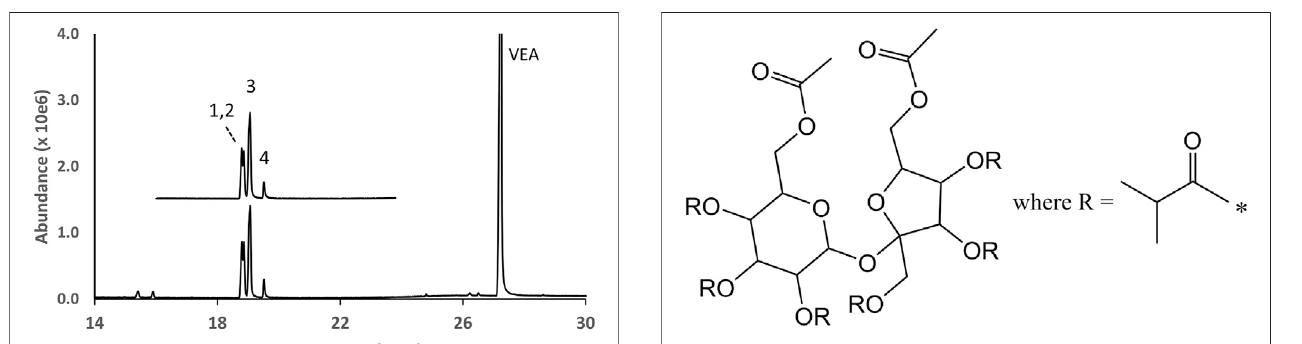
FIGURE 7 | Common representation of SAIB as sucrose diacetate hexaisobutyrate ignoring the variations in the numbers of acetate and isobutyrate moieties and their